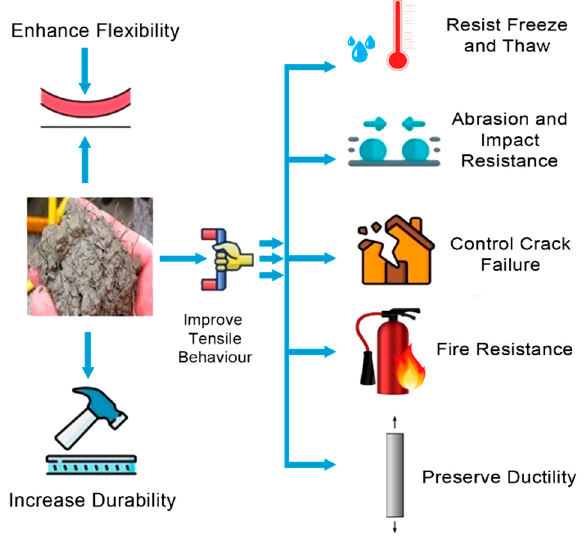
Figure 1. The efficiency of steel fibers in concrete.